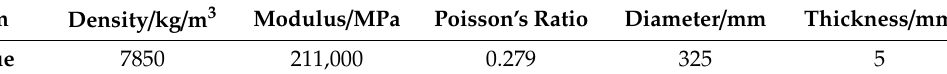
Table 1. Parameters of the 30CrMo steel curved plate.